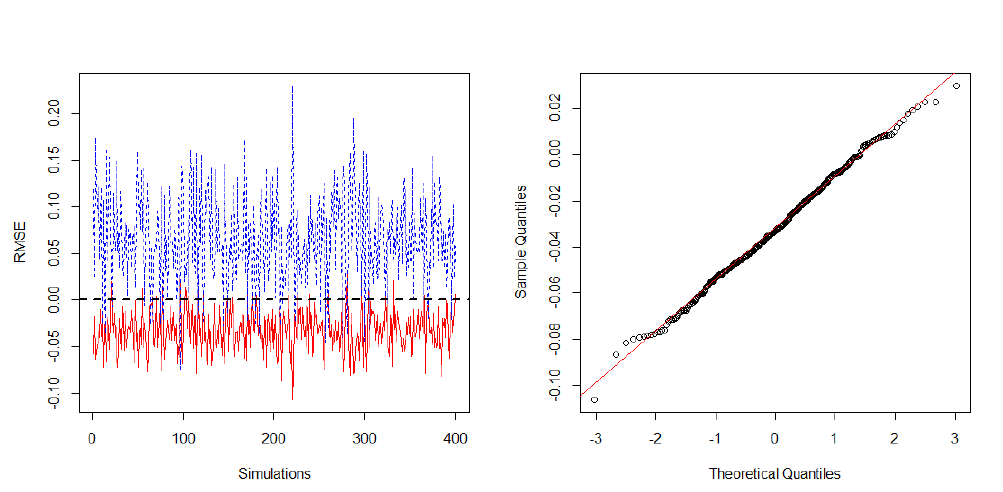
Figure 5: The algorithm’s error, L 1 − expectile, Exponential independent model.